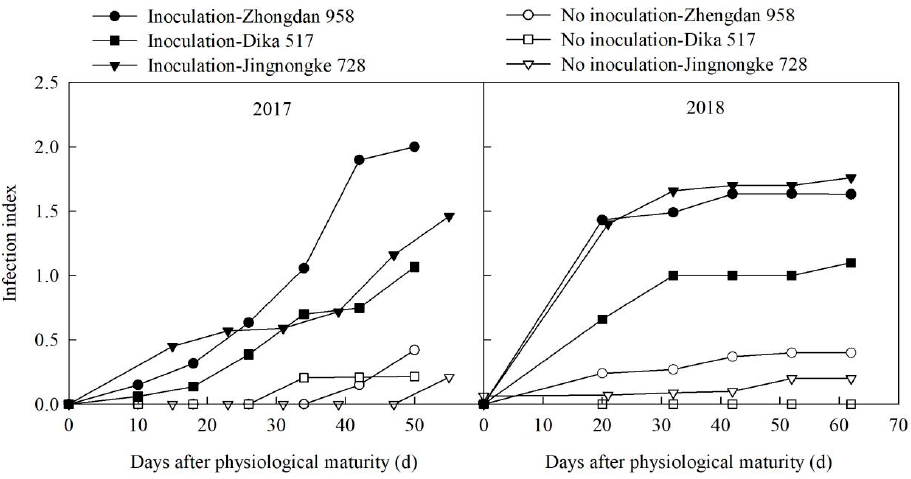
Figure 6. Infection index of different maize cultivars after physiological maturity under inoculation treatment. Different parts of internode cross section were observed to determine the infection process of P. aristosporum . The infection gradually increased from the cortex to center of pith on the 20th day after inoculation (Figure 7). The infection gradually increased with days after inoculation. The vascular bundle of cortex gradually degraded from the 20th day to the 60th day after inoculation (Figure 8).